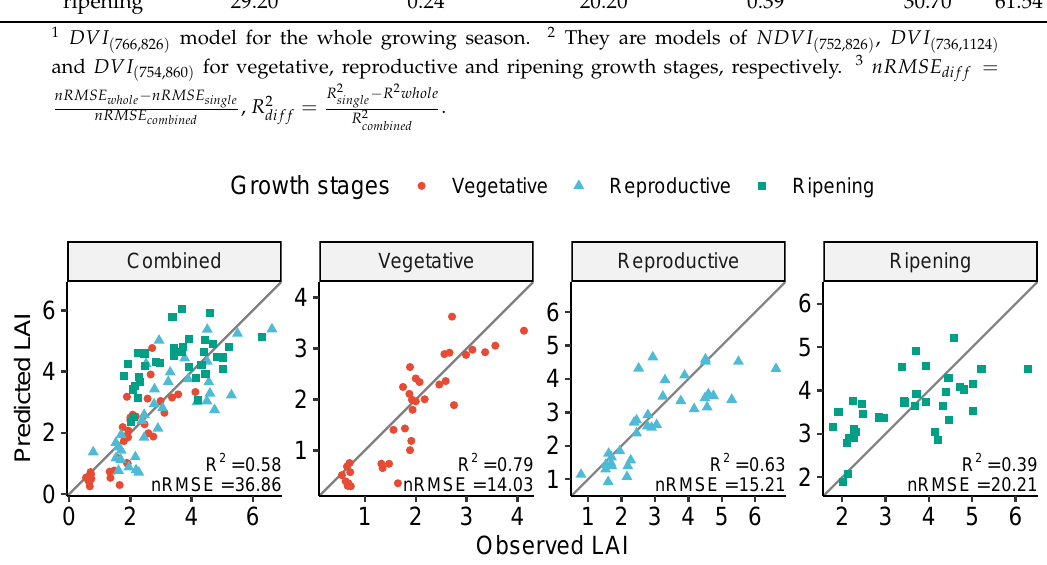
Figure 5. Observed vs. predicted LAI along the 1:1 line on standalone validation dataset of the best-performing VI models (in Table